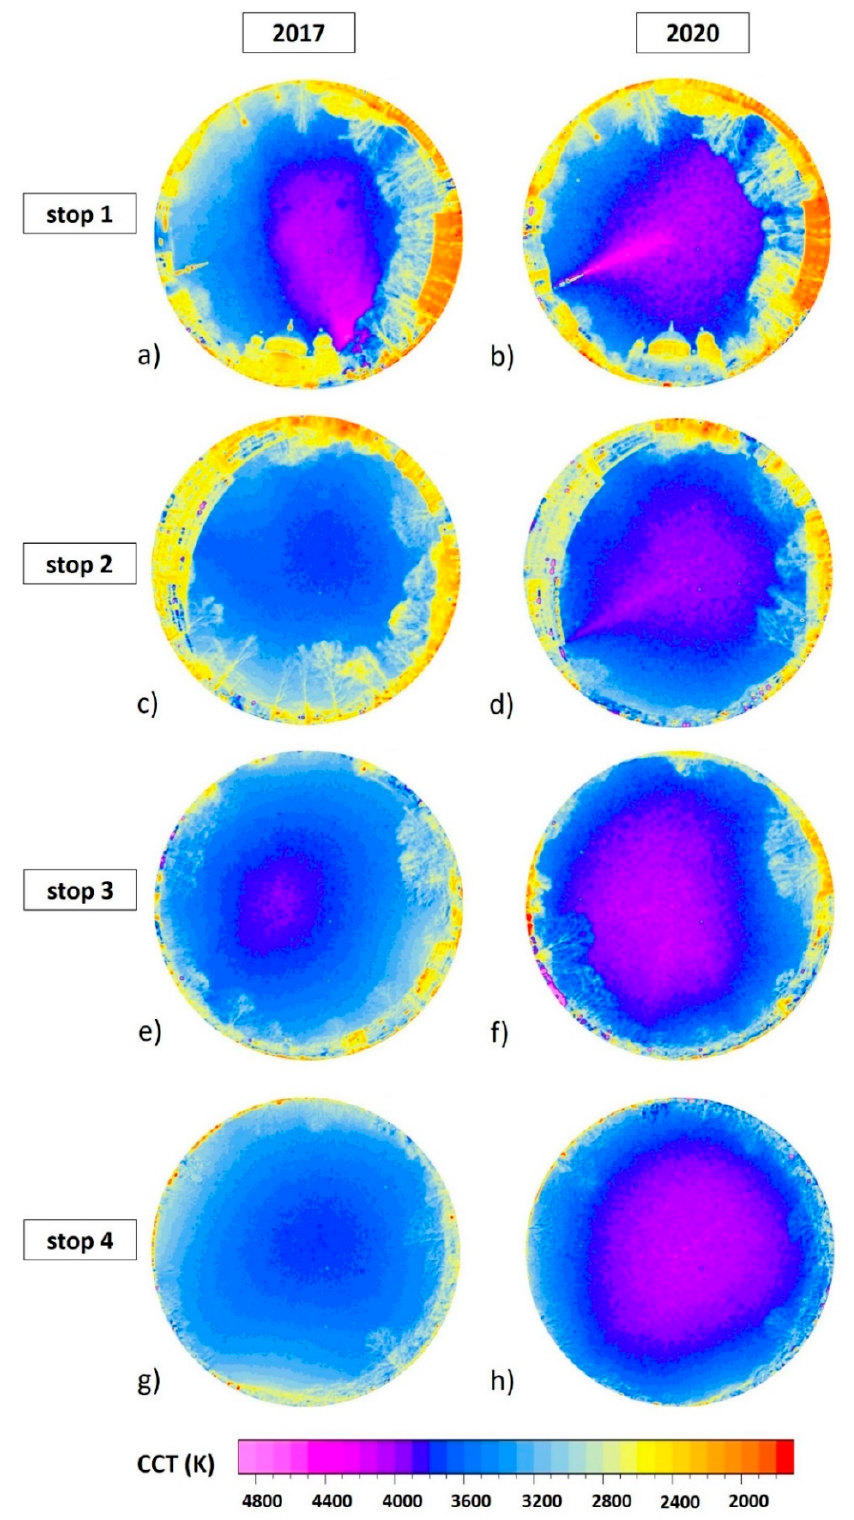
Figure A4. CCT maps for stops 1–4. ( a , c , e , g ) 2017 data, ( b , d , f , h ) 2020 data.